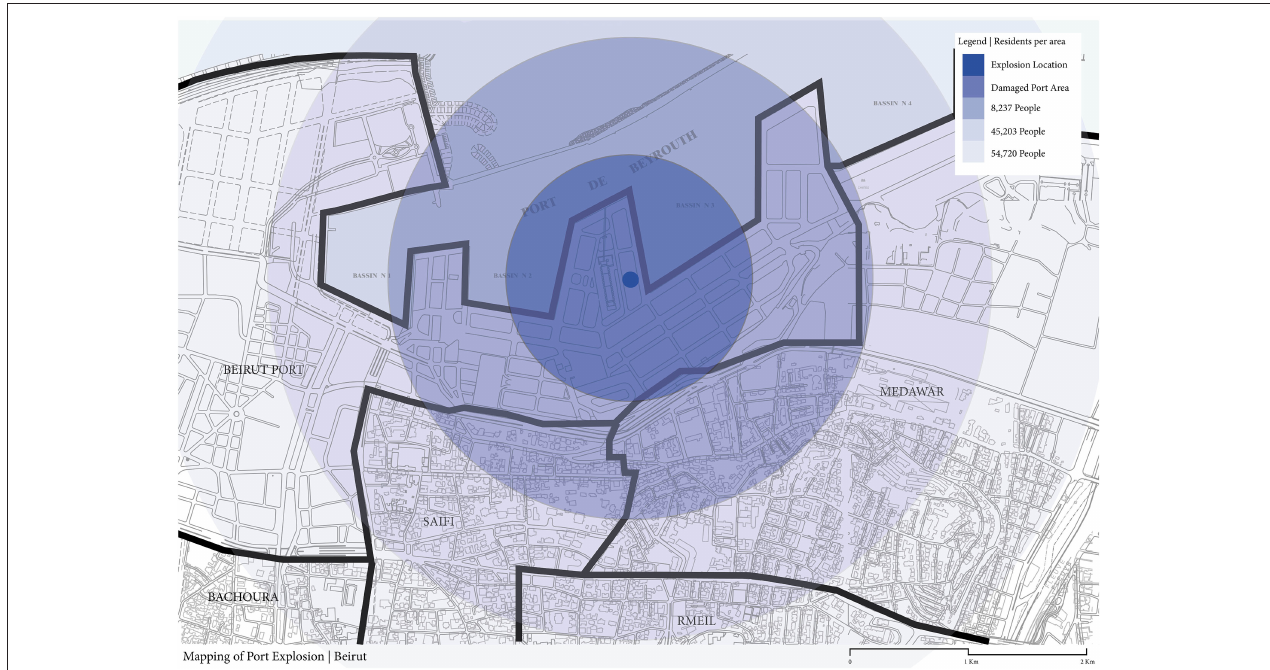
FIGURE 4 | Radius depicting the damages affecting individuals residing at various geographic distances from the blast ranging from 8,237 to 45,203 and reaching out to 54,720 individuals across the Beirut